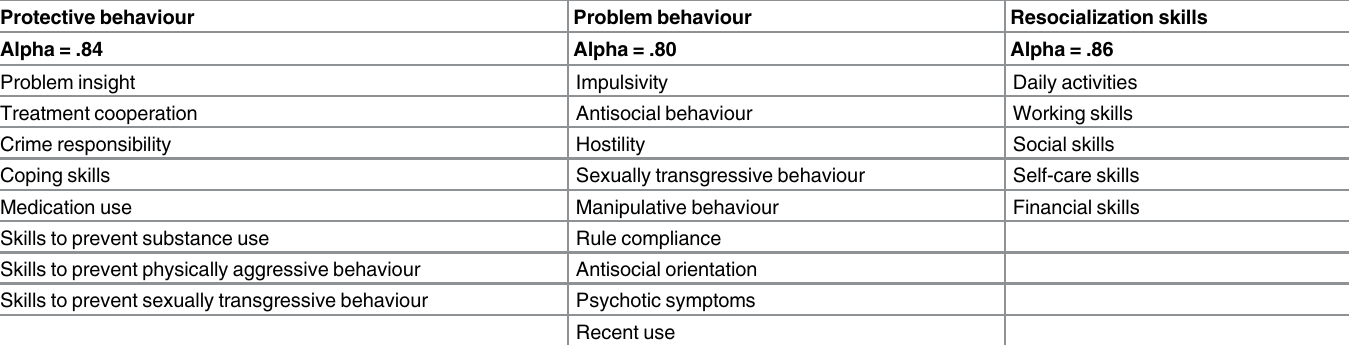
Table 2. The instrument for forensic treatment evaluation and internal